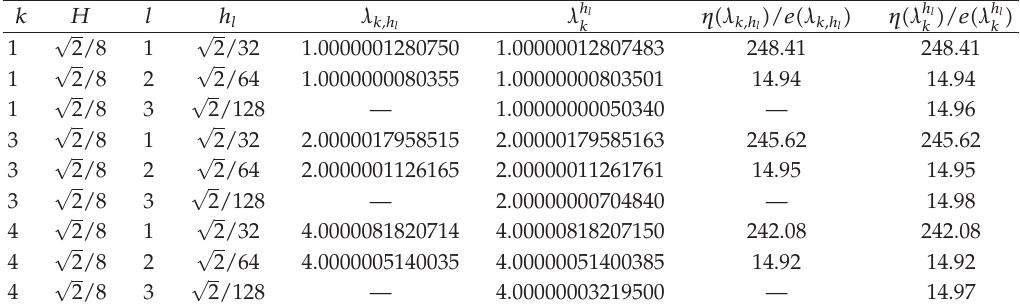
Table 1: The results on the square by Scheme 1 (cid:3) P 2 - P 1 element (cid:6) for the eigenvalue problem of electric field (cid:3) r (cid:8) 0 (cid:6) .